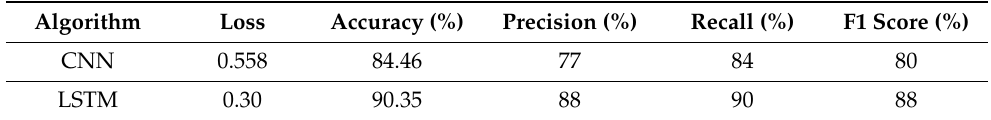
Table 9. Results of deep learning using